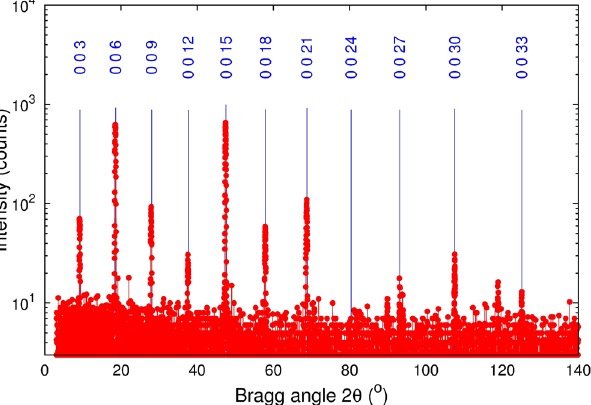
Figure 1. XRD symmetric scan collected from a Bi 2 Se 3 sample. Blue lines denote theoretical positions of the diffraction peaks according to the structural database 15